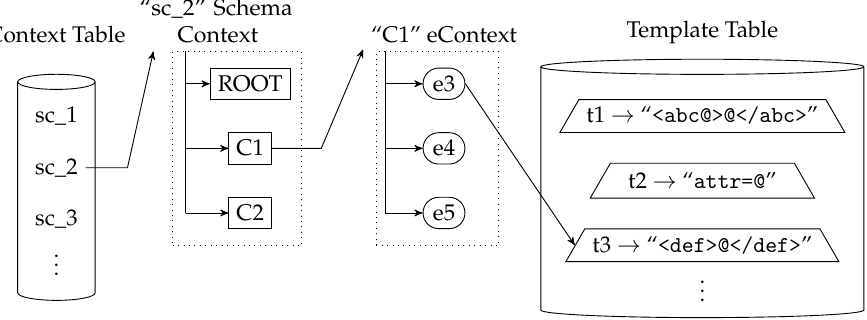
Figure 3. Example of the representation of Context- and Template-based Compression (CTC)